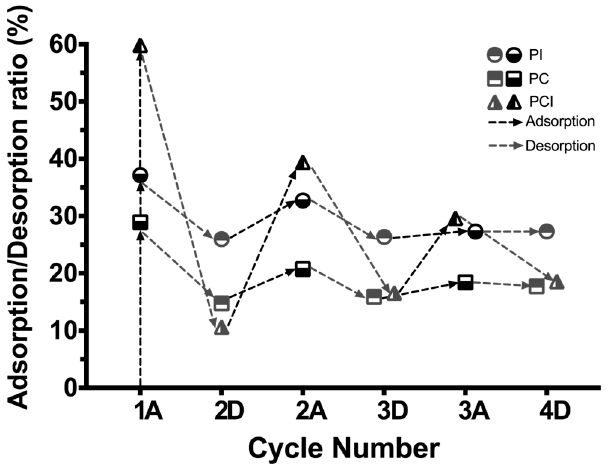
Figure 6. Recycling of blends; adsorption/desorption capacity for four cycles at 25 °C.